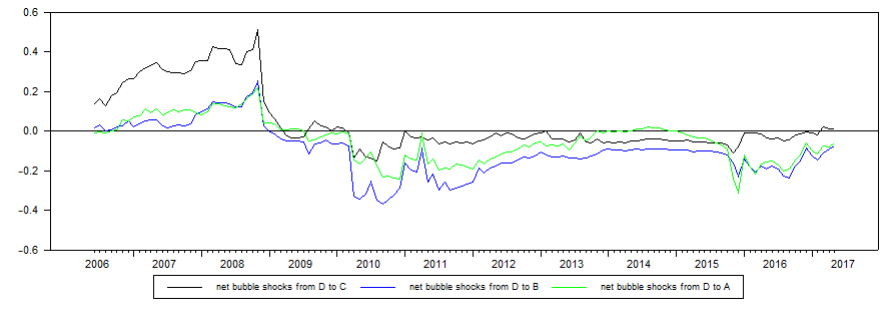
Figure 2. Net bubble spillovers from D to each of the other 3